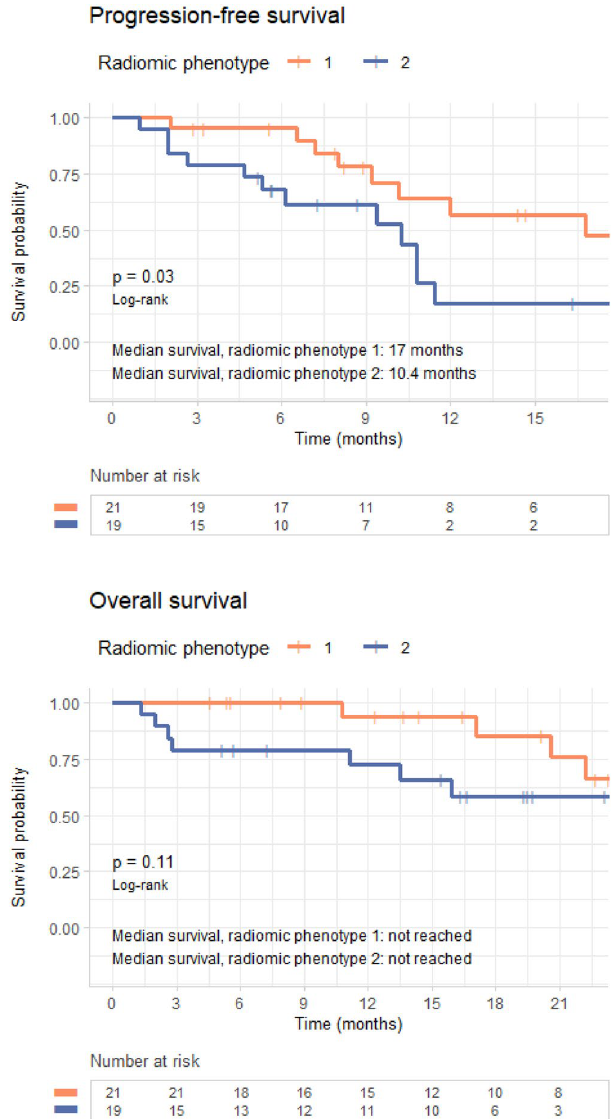
Figure 4. Survival analysis by radiomic phenotype. Progression-free survival (top) and overall survival (bottom) analysis for radiomic phenotypes.